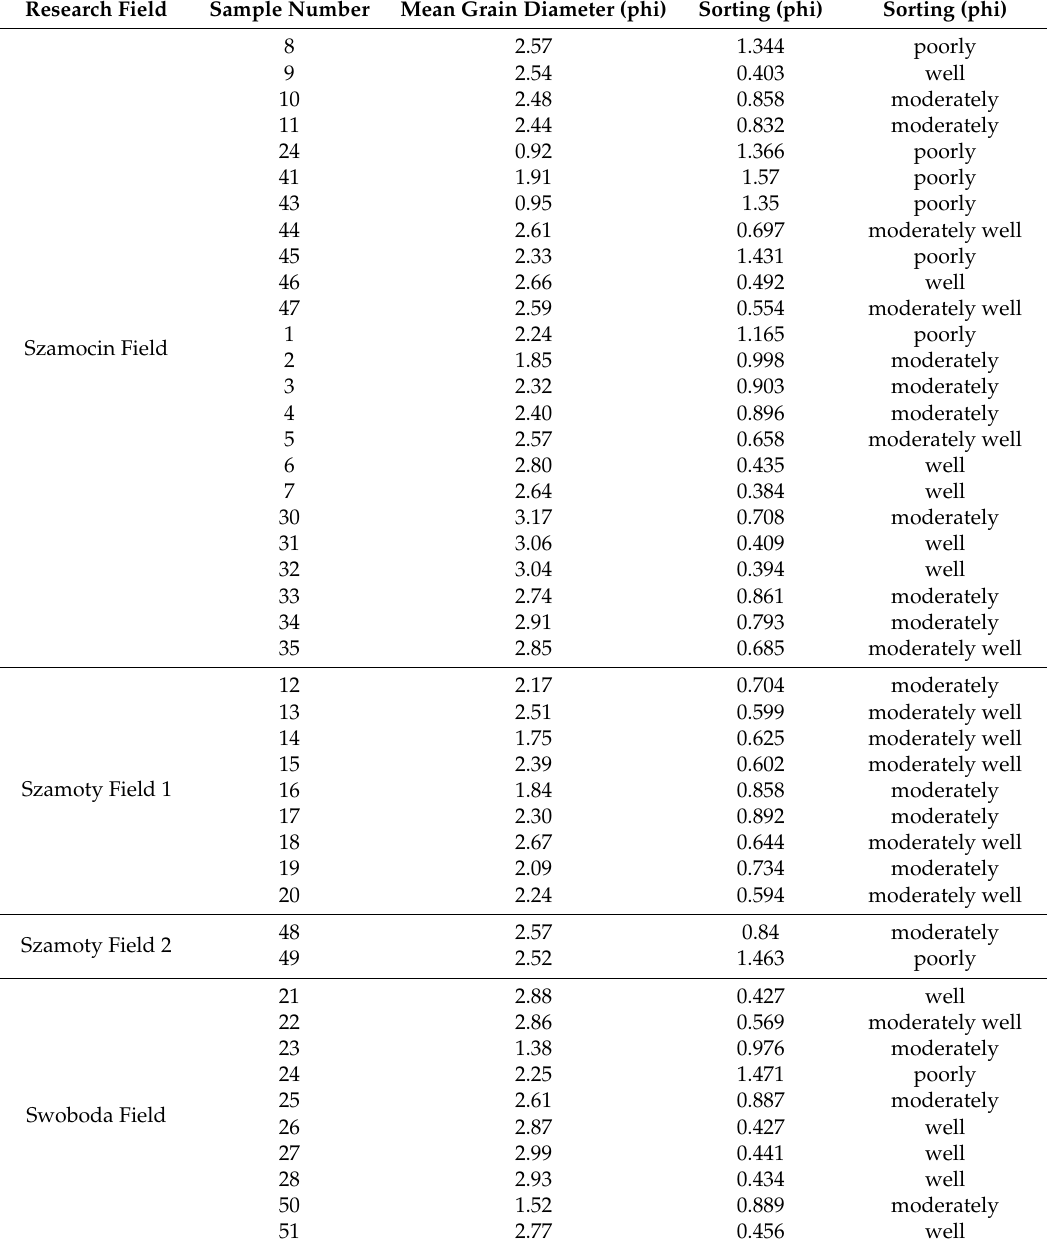
Table 3. Parameters of granulation of collected